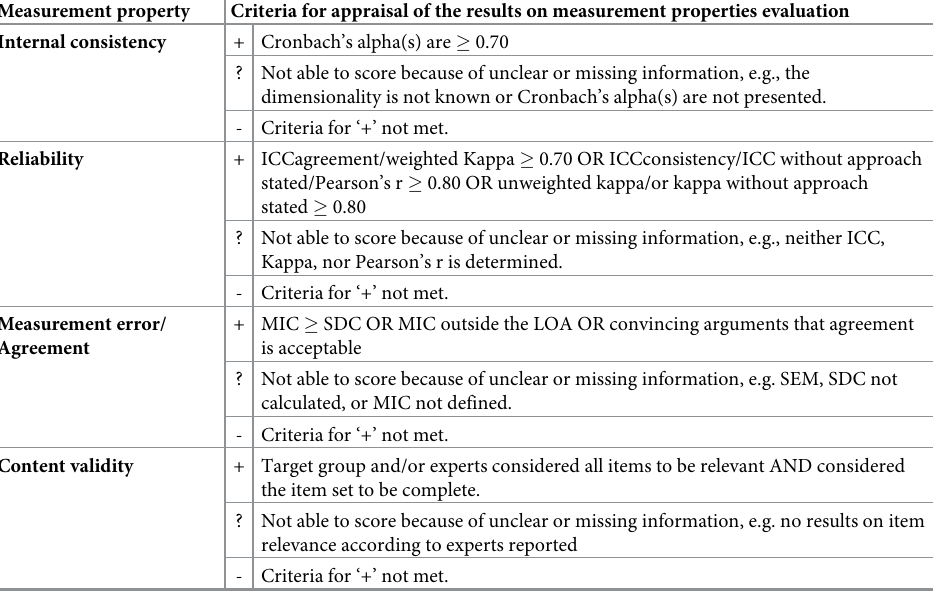
Table 3. Quality criteria for results on measurement properties based on Terwee et al.[21]. Measurement